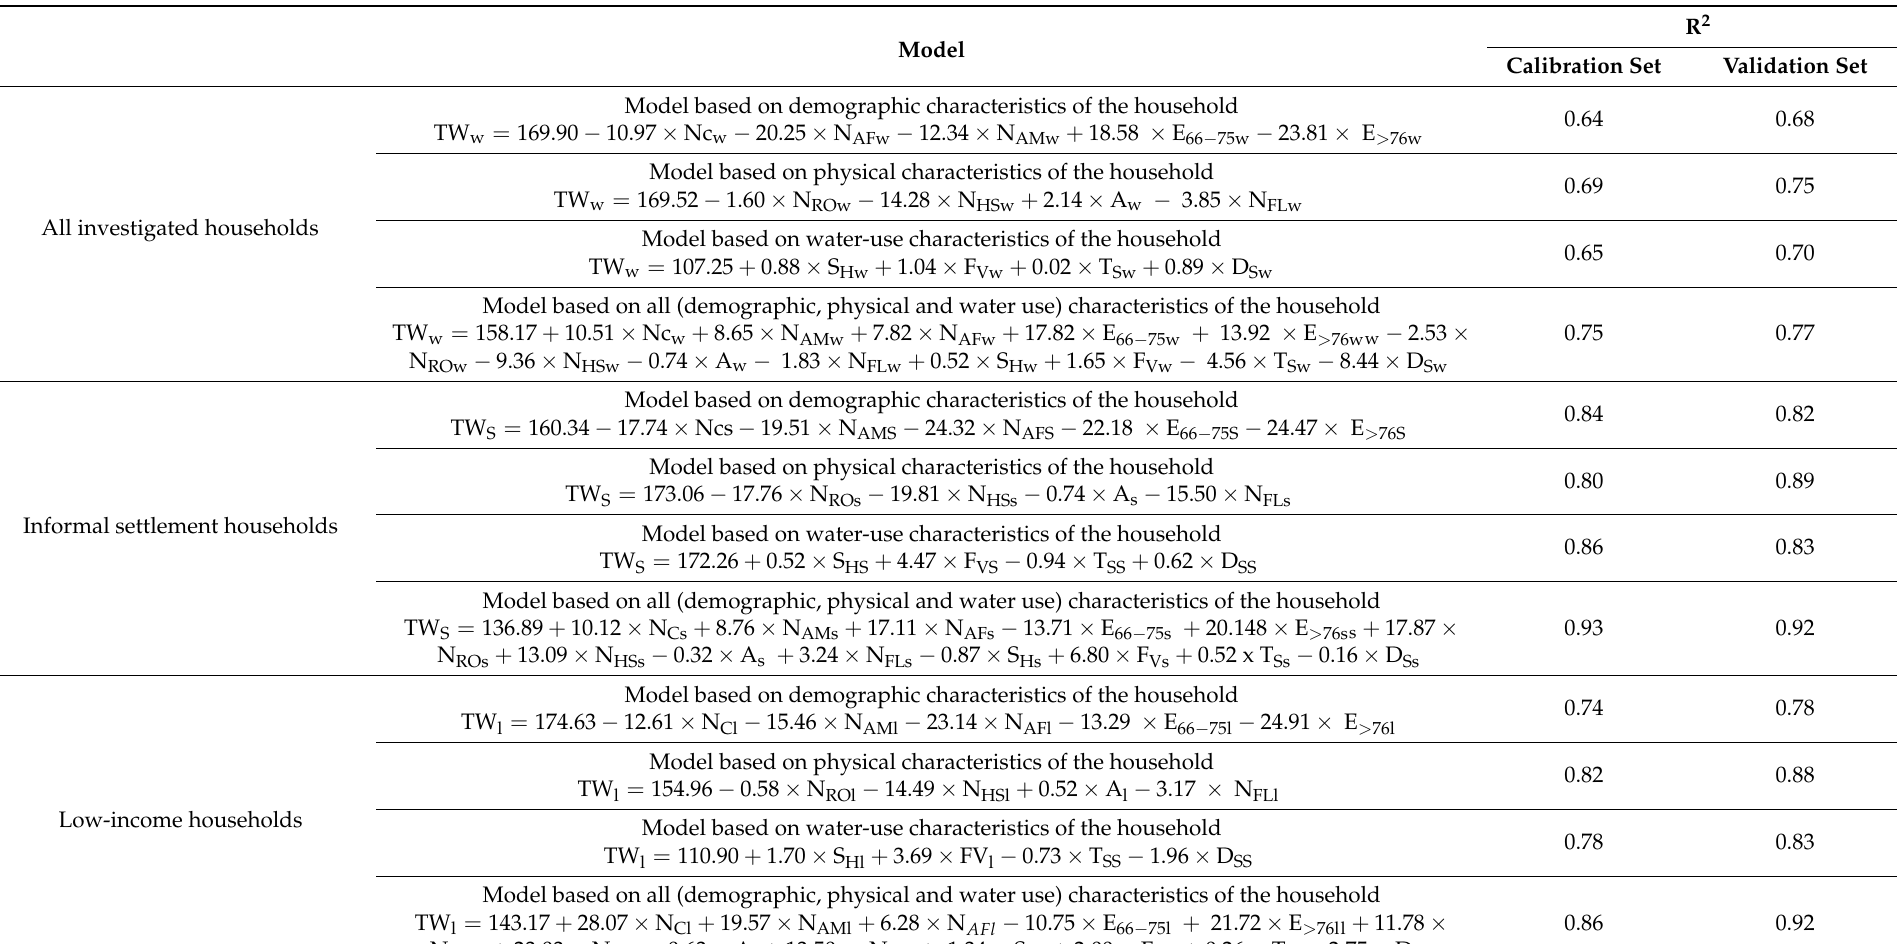
Table A1. Models and coefficient of determination (R2) using multiple linear regression method